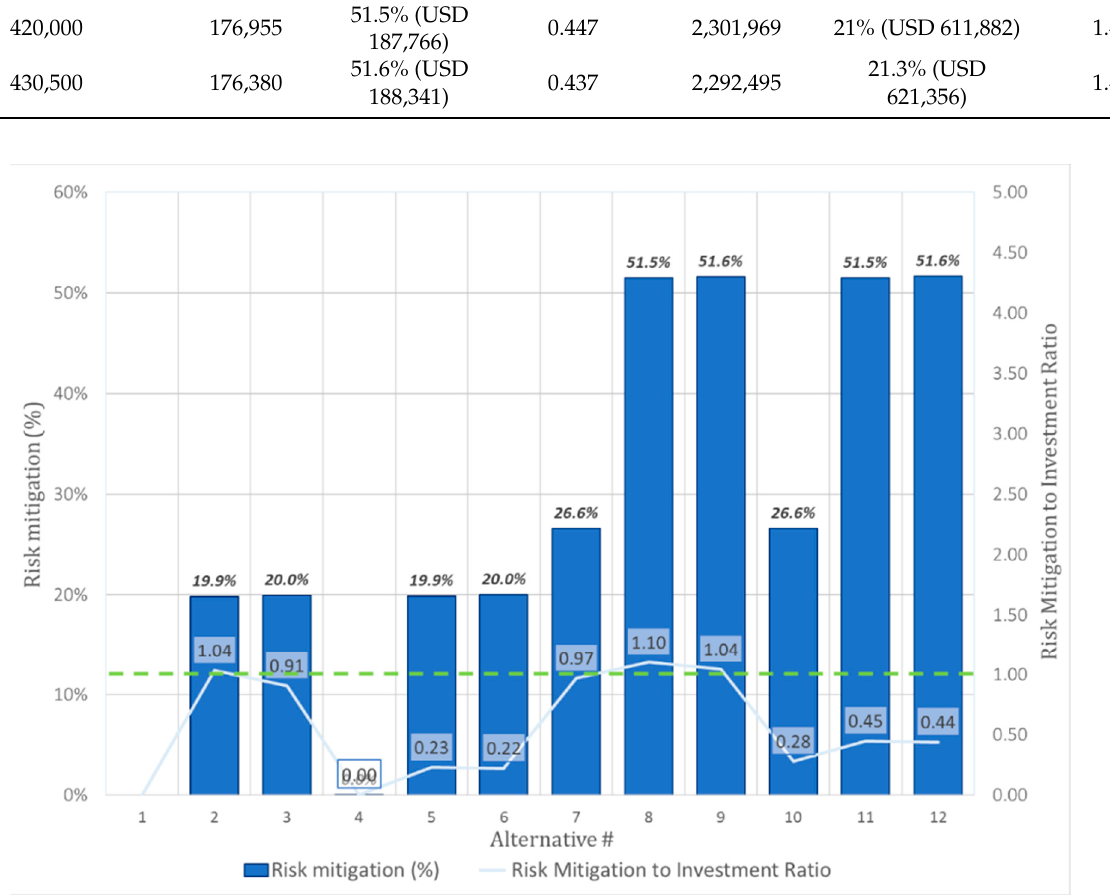
Figure 5. Analysis of the mitigation alternatives by the percentage of risk mitigation and RMIR case of the Be’er Sheva region.